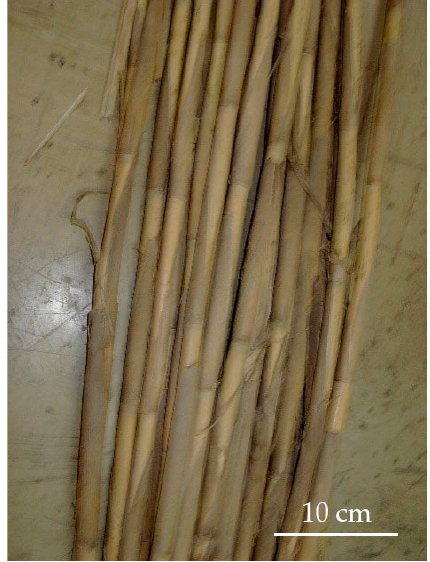
Figure 1. Giant reed used in the manufacturing of the panels. Potato starch from the food industry, with 90% purity, was used as a plasticizer. Chemically, starch is a mixture of two similar polysaccharides: amylose and